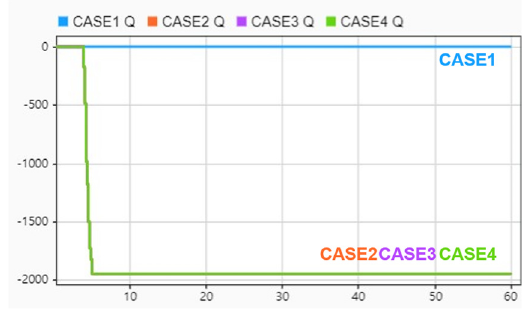
Figure 17. Reactive power output of the G1 Inverter.